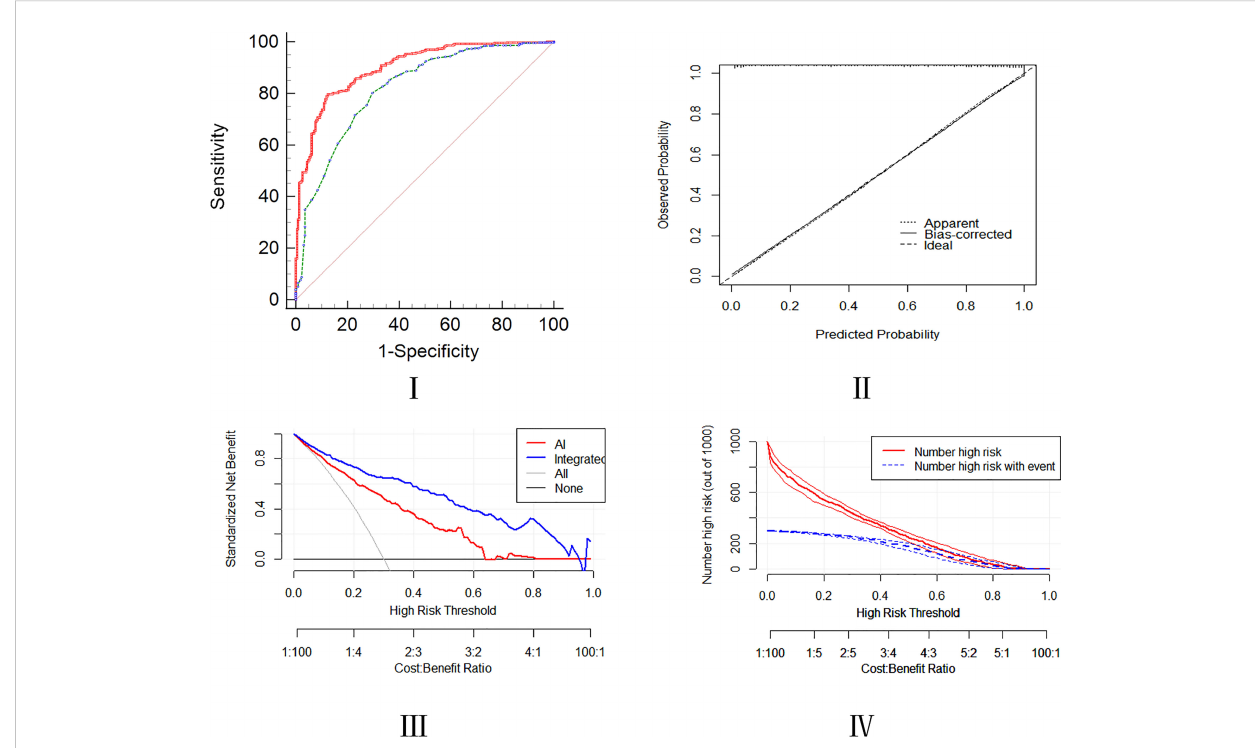
FIGURE 4 Assessment of predictive ability of the integrated model using the ROC, calibration, DCA, and CIC